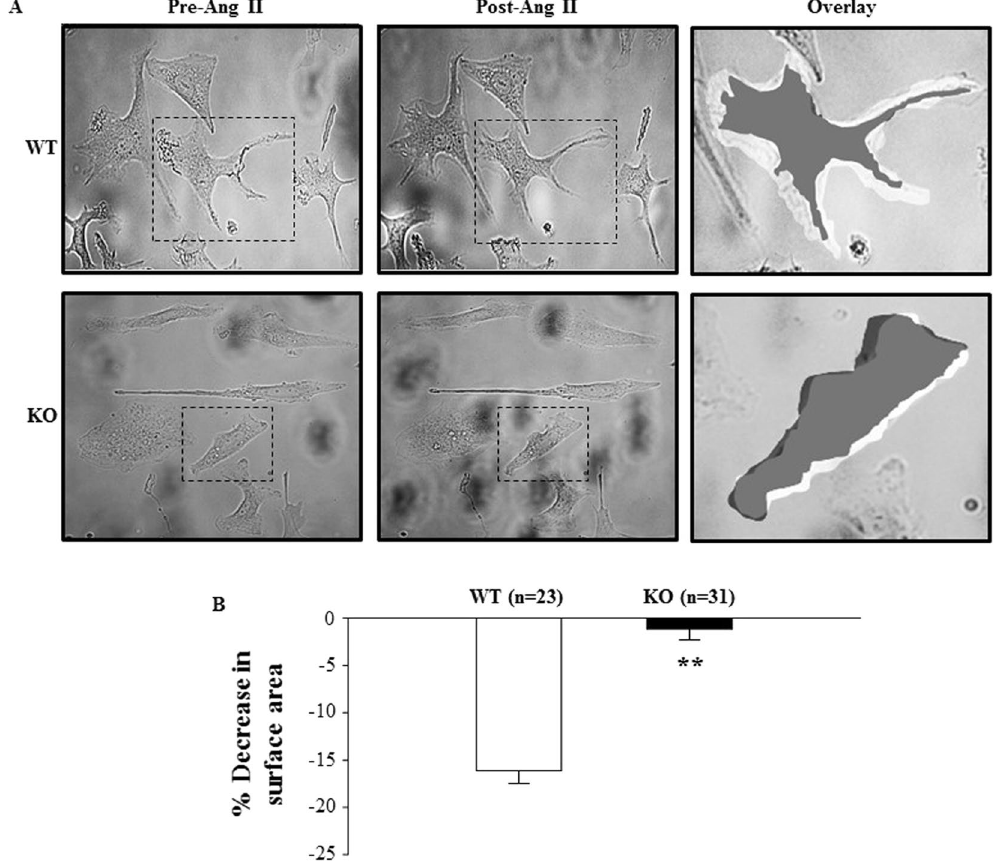
Figure 6. Ang II-induced contraction of primary mouse MCs isolated from TRPC6 WT and KO mice. ( A ) Representative morphology of MCs before and 30 min after 1 μ M Ang II stimulation. The changes in cell size by Ang II are illustrated on the right panel (Overlay), by overlapping the images of the same cell before and after Ang II treatment using Photoshop software. The cells before Ang II treatment were white and after treatment black. The right panels are enlarged regions indicated by the dashed rectangles in the left and middle panels. ( B ) Summary data in 23 normal MCs from 8 WT mice and 31 TRPC6 deficient MCs from 10 KO mice, showing the Ang II-induced decreases in the surface area of MC with and without TRPC6. ** Denotes P < 0.01, KO vs.